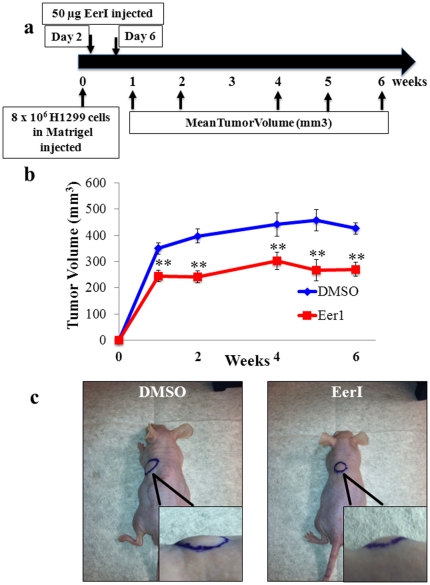
Inhibition of VCP's function by EerI reduces tumor growth in NSCLC-xenograft model.(a) Tumors were established in athymic nude mice by subcutaneous (s.c.) injection of H1299 (8×106) cells complexed with Matrigel into the upper left flank. Mice were randomized into two groups (n = 5) and treated with EerI (50 µg, 2 doses at indicated times as on the scale) or DMSO vehicle. (b) Primary tumor growth was measured volumetrically over time and statistical analysis of data is shown as mean ± SEM. EerI treatment significantly reduced tumor volume as compared to the DMSO vehicle control ** p<0.01). (c) Representative images captured on Day 8 illustrate the difference in tumor volumes between the two groups. VCP can be therapeutically targeted using EerI or other potent VCP-inhibitor to control NCLSC tumor growth and/or progression.